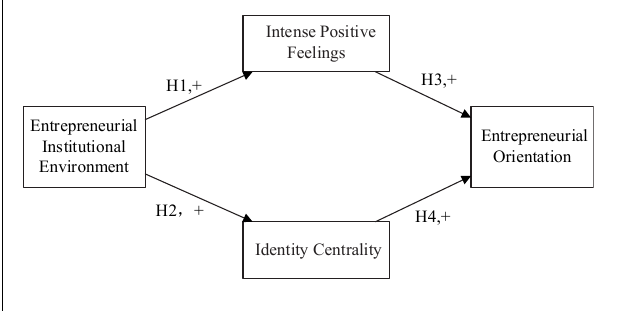
FIGURE 1 | Conceptual